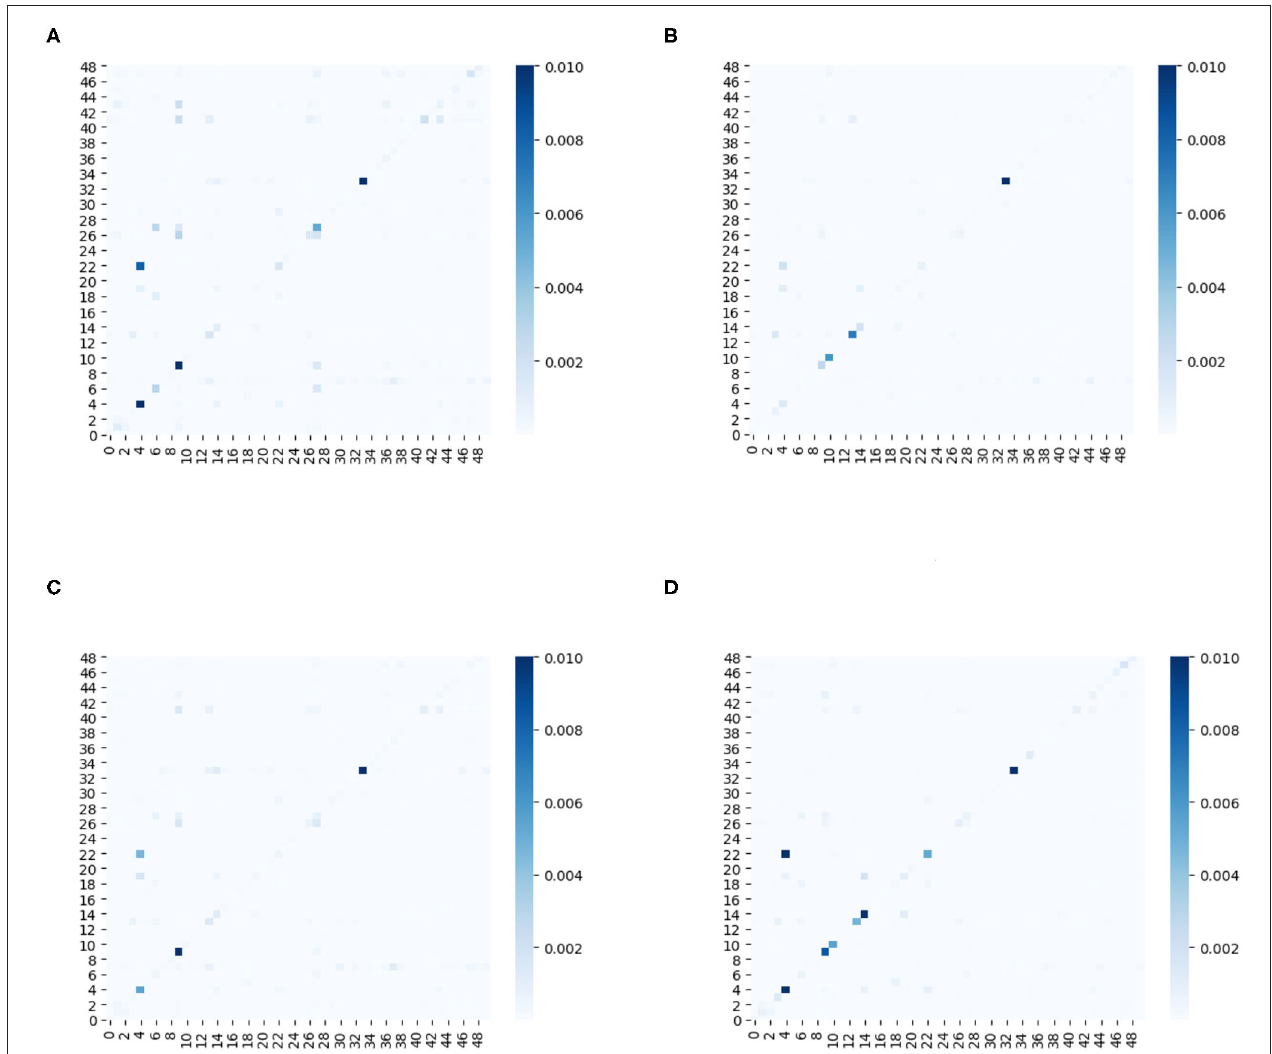
FIGURE 9 | (A–D) The heat maps of adjacency matrixes for the first 50 sensors at four different time